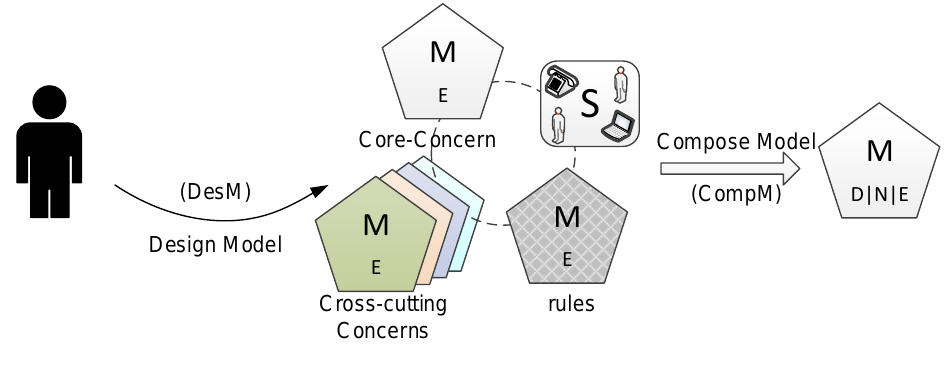
Figure 3. The Static Weaving use case [1]